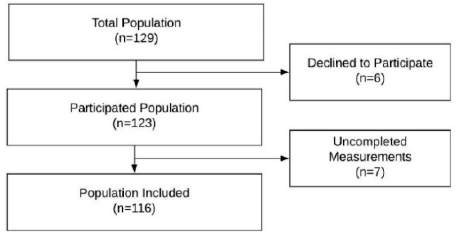
Figure 1. Population flow chart diagram.